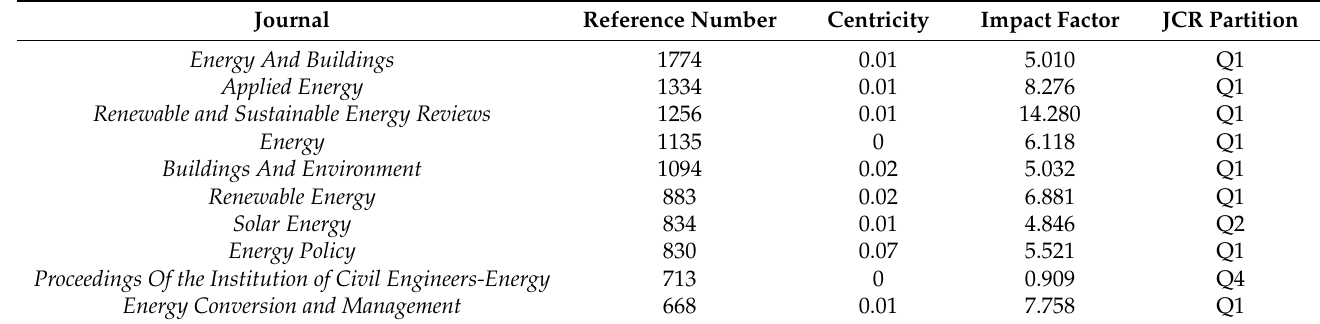
Table 7. Most frequently cited journals and their related information.